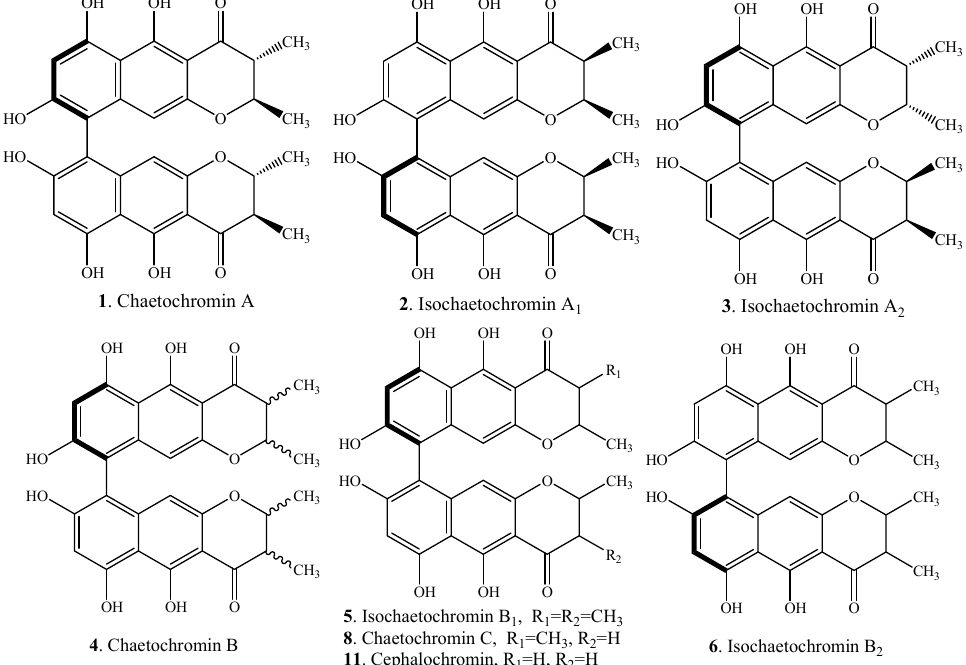
Figure 1. Structures of chaetochromin-type bis-naphtho- γ -pyrones ( 1 – 26 ) from